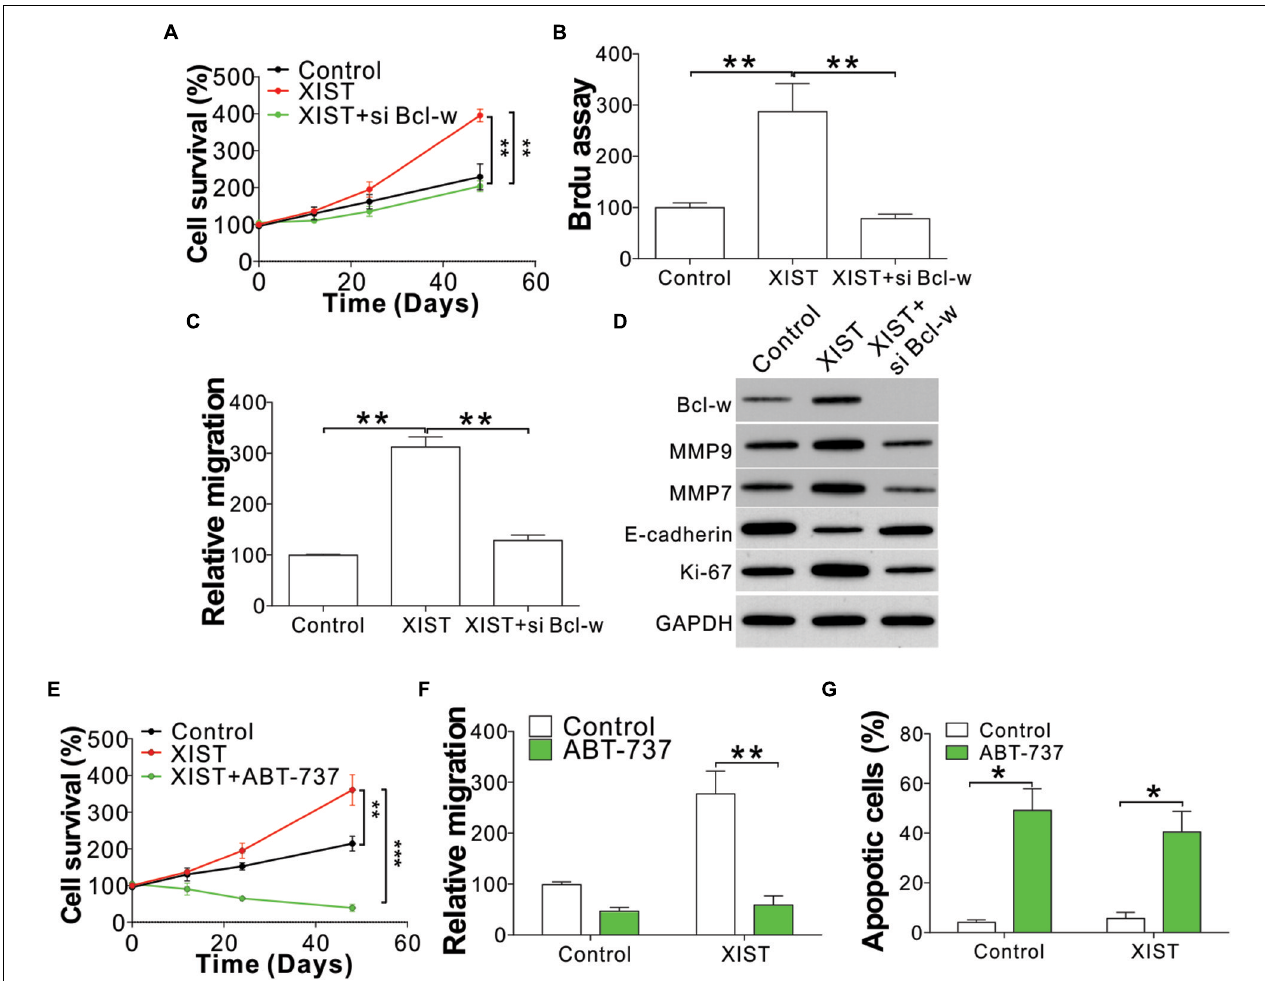
FIGURE 6 | Deletion or inhibition of Bcl-w suppressed the proliferation and migration of ENKL cells with high XIST expression. (A) The cell viability of NK-92 cells with a stably transfected control or XIST expression vector with co-transfection of Bcl-w siRNA. (B) BrdU assay analysis of NK-92 cells with a stably transfected control or XIST expression vector with co-transfection of Bcl-w siRNA. (C) Transwell assay analysis of NK-92 cells with a stably transfected control or XIST expression vector with co-transfection of Bcl-w siRNA. (D) The indicated protein expression in NK-92 cells with a stably transfected control or XIST expression vector with co-transfection of Bcl-w siRNA. (E) The cell viability of NK-92 cells with stably transfected control or XIST expression vector with or without ABT-737 (4 µ M) treatment. (F) The migration of NK-92 cells as treated in panel (E) . (G) Hoechst-33258 staining of the nucleus for apoptosis in NK-92 cells as treated in panel (E) . Each experiment was repeated for 3 times. * p < 0.05; ** p < 0.01; *** p <